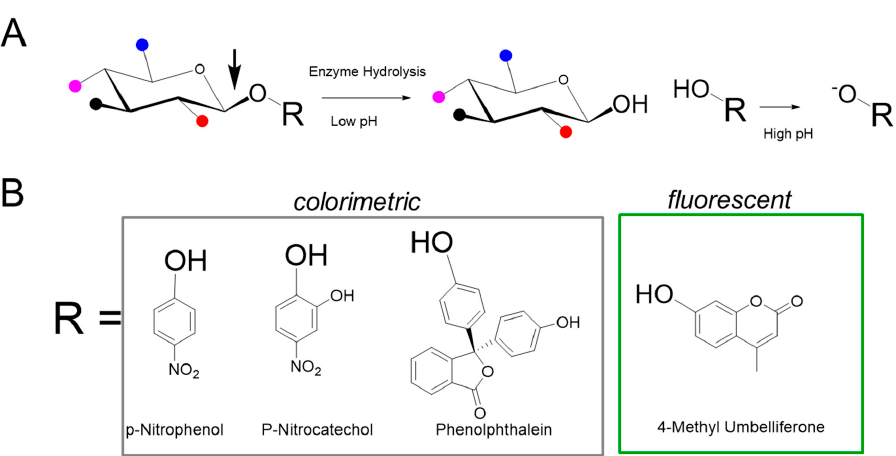
Figure 2. Synthetic substrates for MPS enzyme measurement. ( A ) The generic structure of the substrate is composed of a specific saccharide, conjugated to an aglycone (R group). Various functional groups are indicated by colored balls, for example red for sulfate, and are attached to the sugar. The enzyme of interest cleaves the glycosidic bond denoted by the arrow to release R, which is then exposed to high pH conditions to generate signal. ( B ) Examples of aglycone moieties typically used in colorimetric and fluorescence based assays.